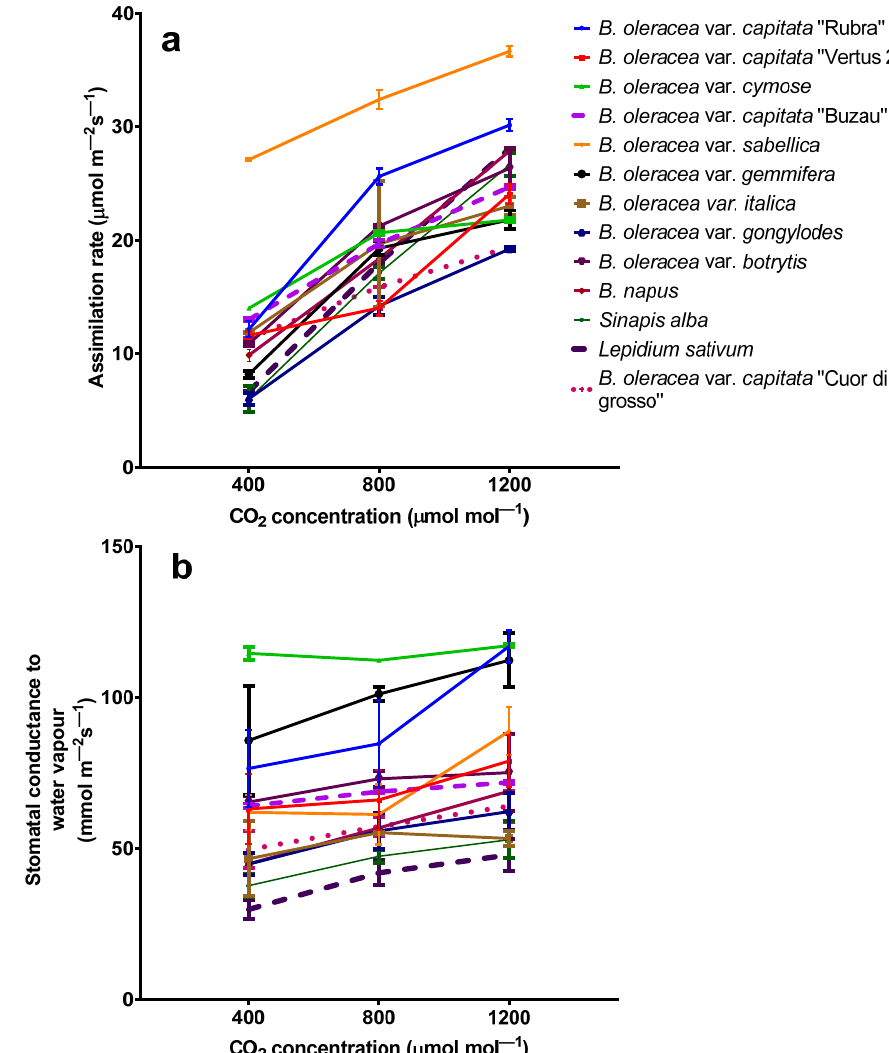
Figure 1. The assimilation rate ( a ) and stomatal conductance to water vapor ( b ) from Brassicaceae plants grown at three carbon dioxide concentrations. The values are averages of three independent measurements.